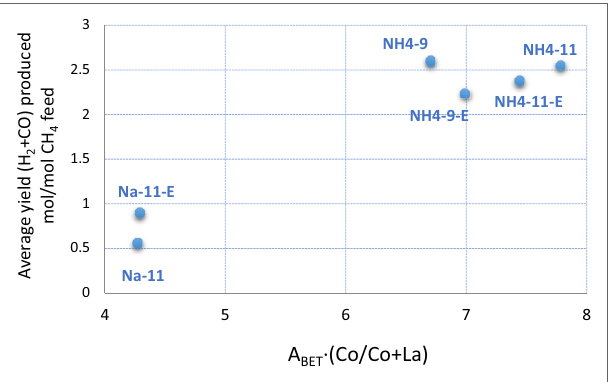
FigUre 8 | Correlation between A BET ·[Co/(Co + La)] and yield to syngas by catalytic partial oxidation of methane (CPOM) for the catalysts derived from LaCoO 3